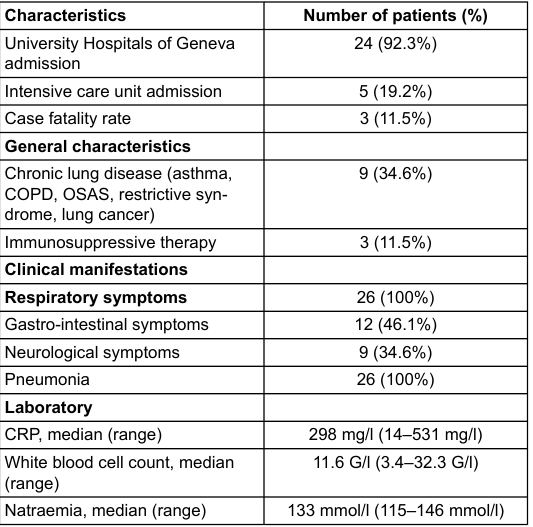
Table 1: Clinical characteristics of confirmed cases of Legionnaires’ disease with completely available medical information (n = 26).